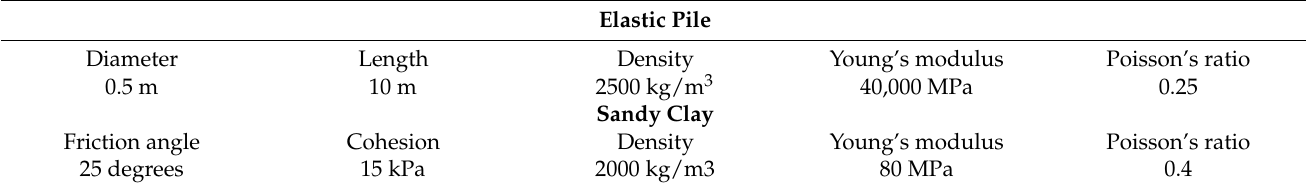
Table 1. Soil and pile material